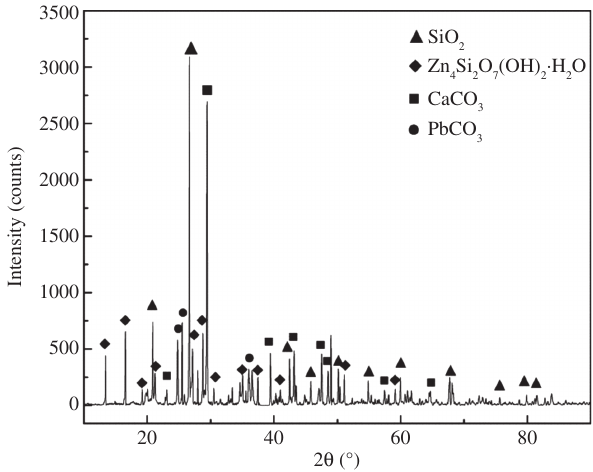
Figure 1: X-ray diffraction pattern of low grade zinc oxide ore.